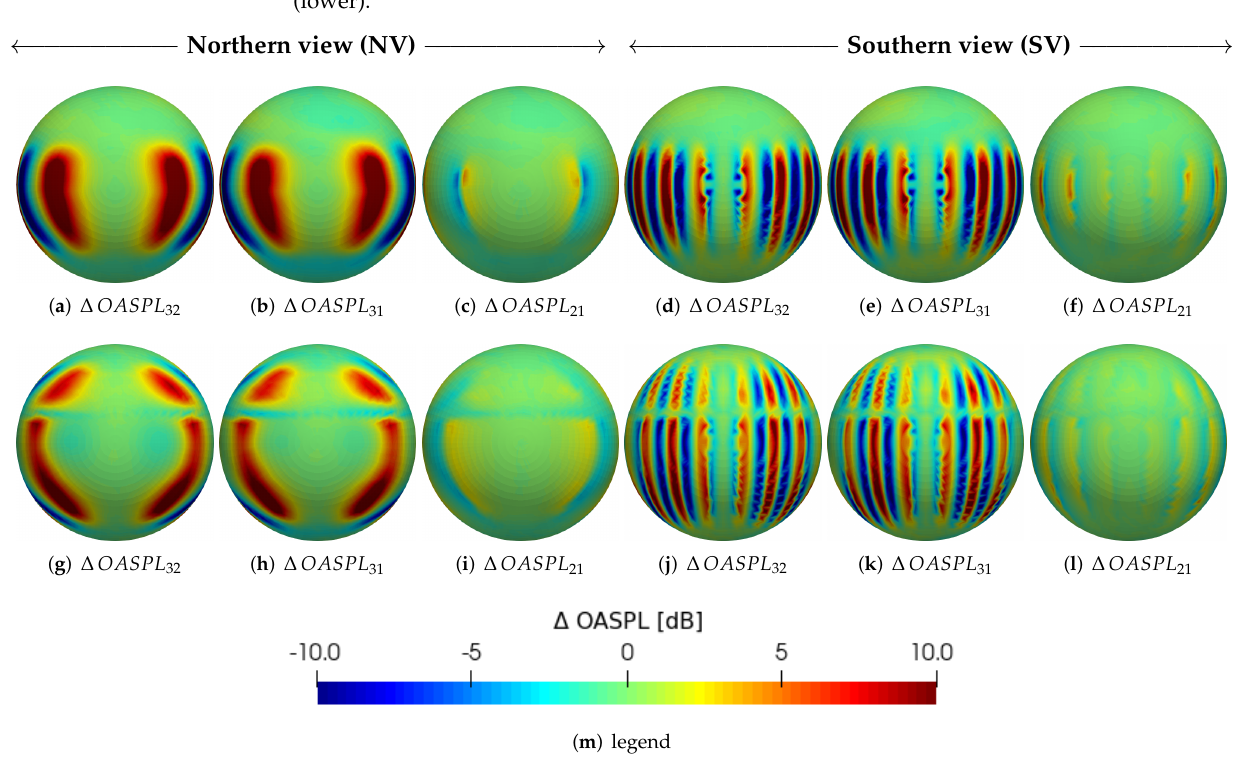
Figure 3. Counter-rotating configuration, OASPL difference vs. TC difference, for M t = 0.52 (upper) and M t = 0.7